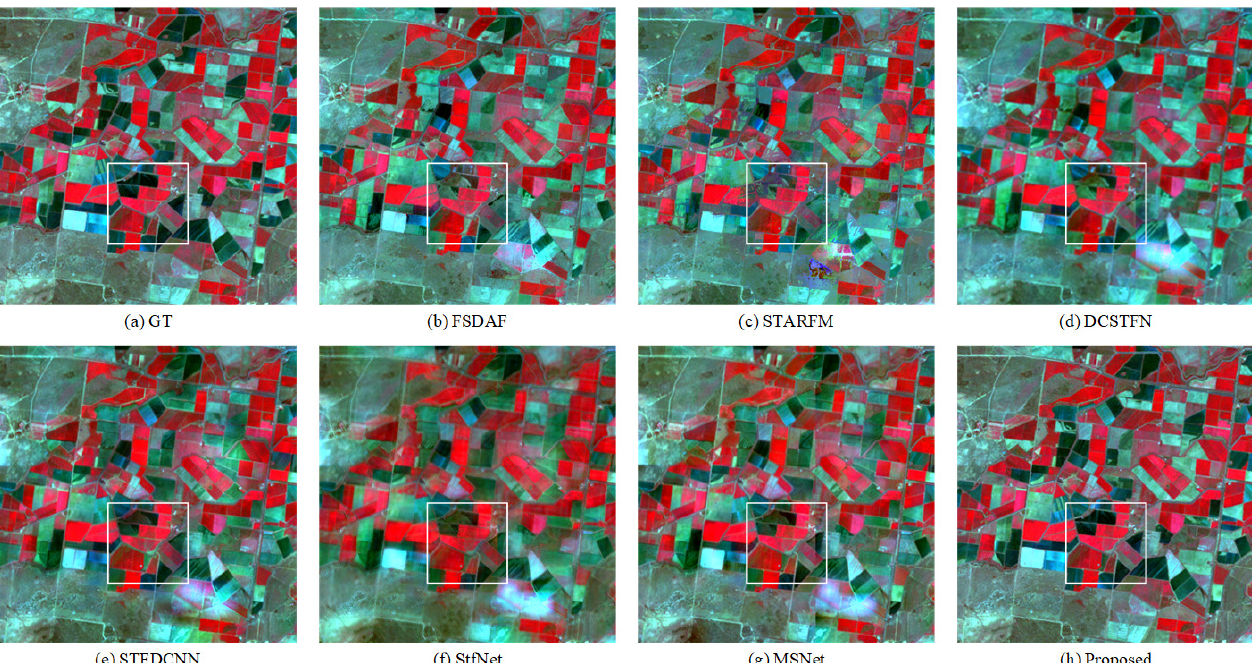
Figure 8. Specific prediction results for the target Landsat image (16 October 2001) in CIA dataset. Among them, the white framework is the prominent difference of the results obtained by each method. Comparison methods include FSDAF [11], STARFM [8], DCSTFN [23], STFDCNN [18], StfNet [19], and MSNet [36], which are represented by ( b – g ) in the figure respectively. ( a ) represents the ground truth (GT), and ( h ) represents the proposed method.